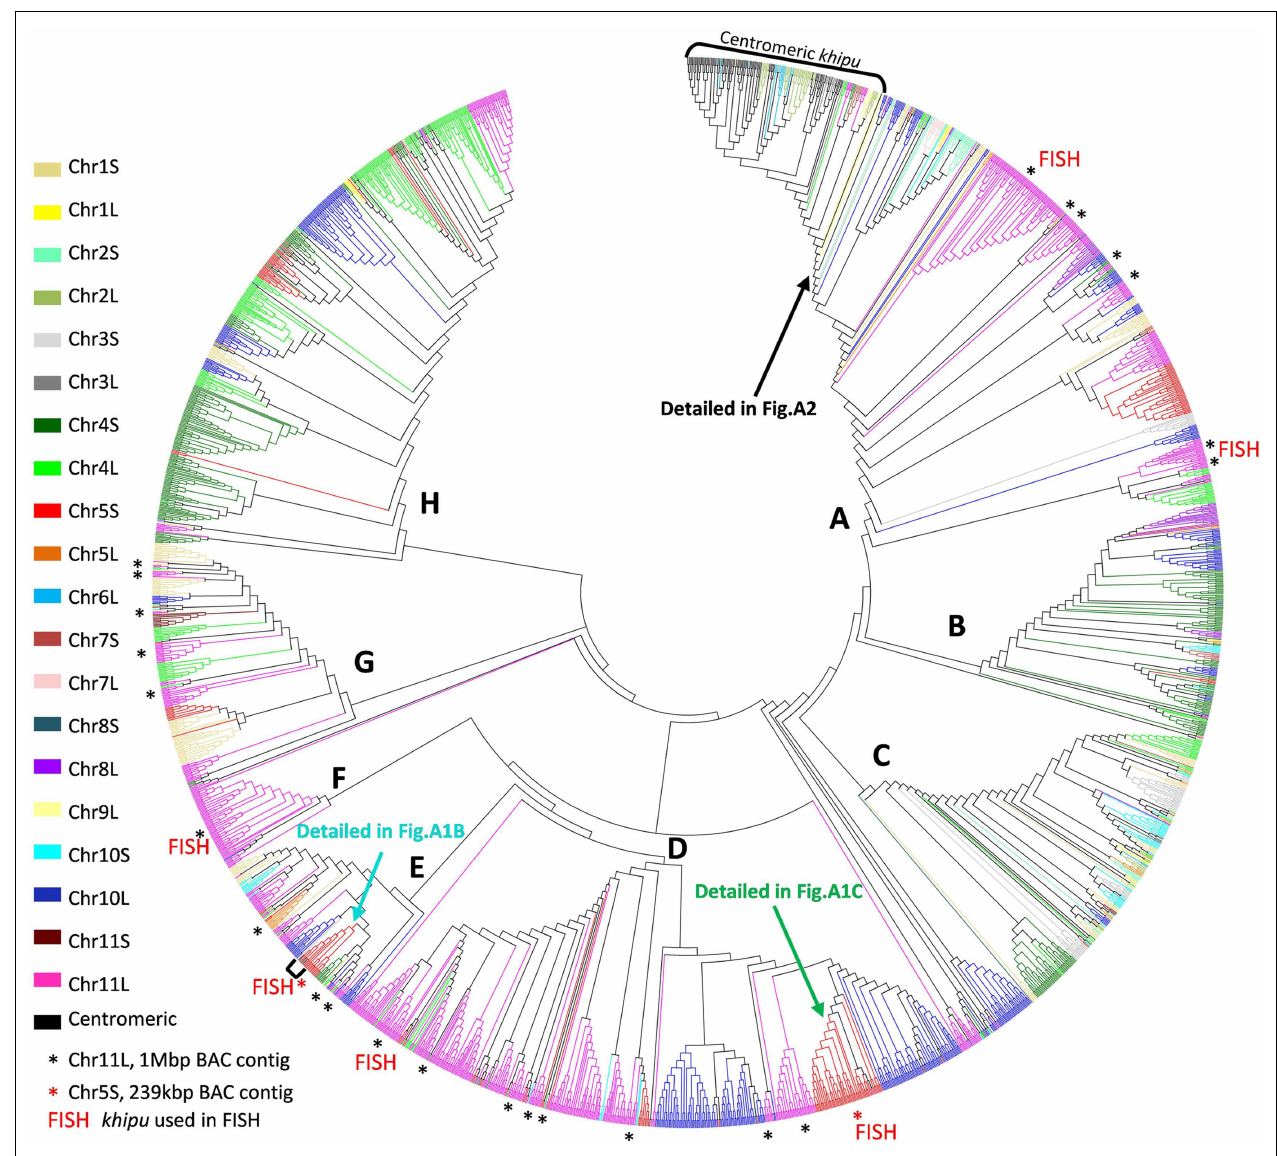
Note that centromeric khipu repeats (black) are found only in two small subclades highlighted by brackets. Clades comprising khipu repeats from previously sequenced BAC contigs from chromosome 11 long arm or chromosome 5 short arm are highlighted by black or red asterisks, respectively. Clades comprising khipu repeats used for FISH experiments are highlighted by FISH written in